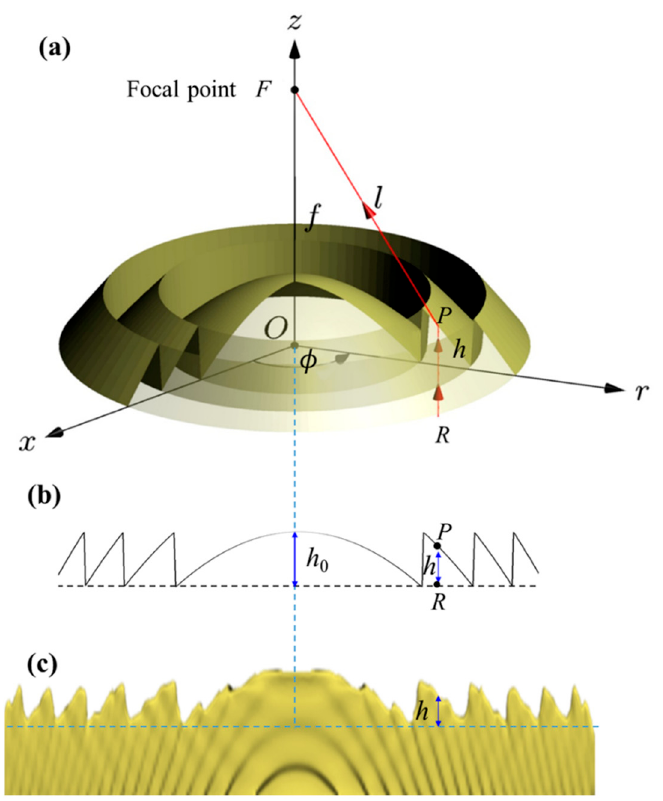
Figure 1. ( a ) Schematic of a continuous surface Fresnel lens; ( b ) cross section of the designed Fresnel lens; ( c ) corresponding slice of the focal filed intensity generated by 3D focal field engineering.